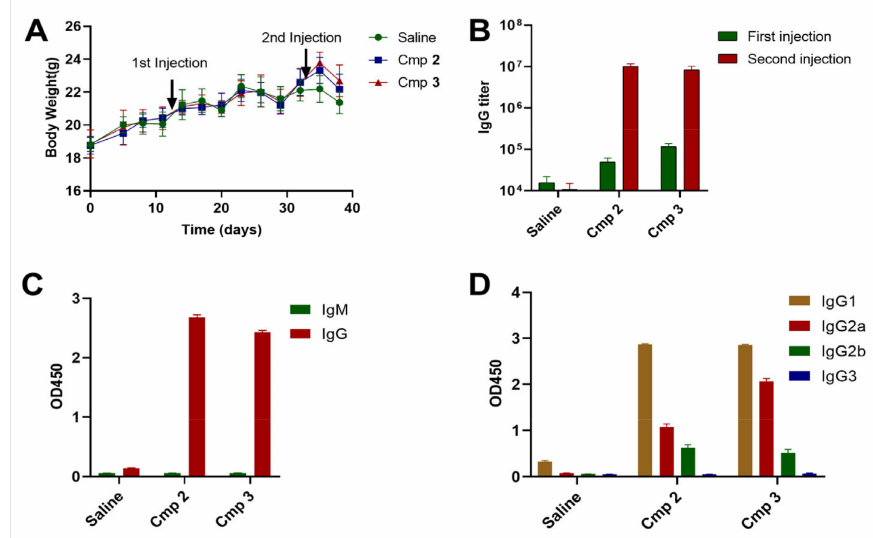
Figure 3. Compound 3 as an effective vaccine adjuvant for SARS-CoV2 RBD trimer antigen. Balb/c mice were injected subcutaneous with saline, compound 2 +antigen, and compound 3 +antigen two times at 3-week intervals. ( A ) Body weight was measured at the indicated times (n ≥ 5). ( B ) The total antibody IgG titers of different individuals’ sera derived from mice after first or second immunization. ( C , D ) IgM, IgG, and IgG subtypes include IgG1, IgG2a, IgG2b, and IgG3 levels against the RBD protein of the pooled sera (sera 1:200,000 dilution); all antisera were collected two weeks after the second immunization. Each data represents the total OD450 absorbance value. The data are presented as the mean ± SD (n ≥